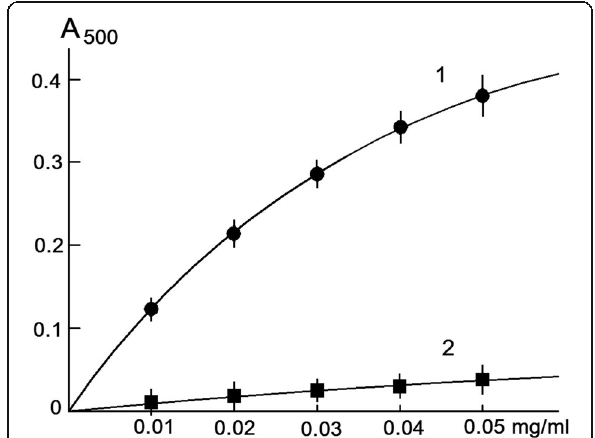
Fig. 5 Formation of adrenochrome as a result of oxidation of adrenaline by superoxide radicals produced by suprol associated fraction of Nox of different concentrations at pH 7.4 in the absence of (1 - ● -) and presence of 5.10 − 8 M Cu, Zn-SOD (2 - ■